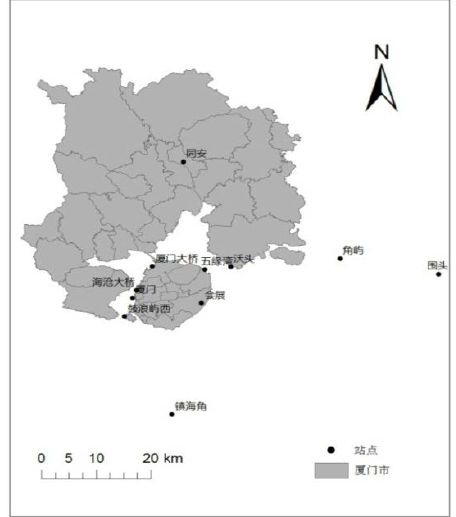
Figure 1. Study area and meteorological